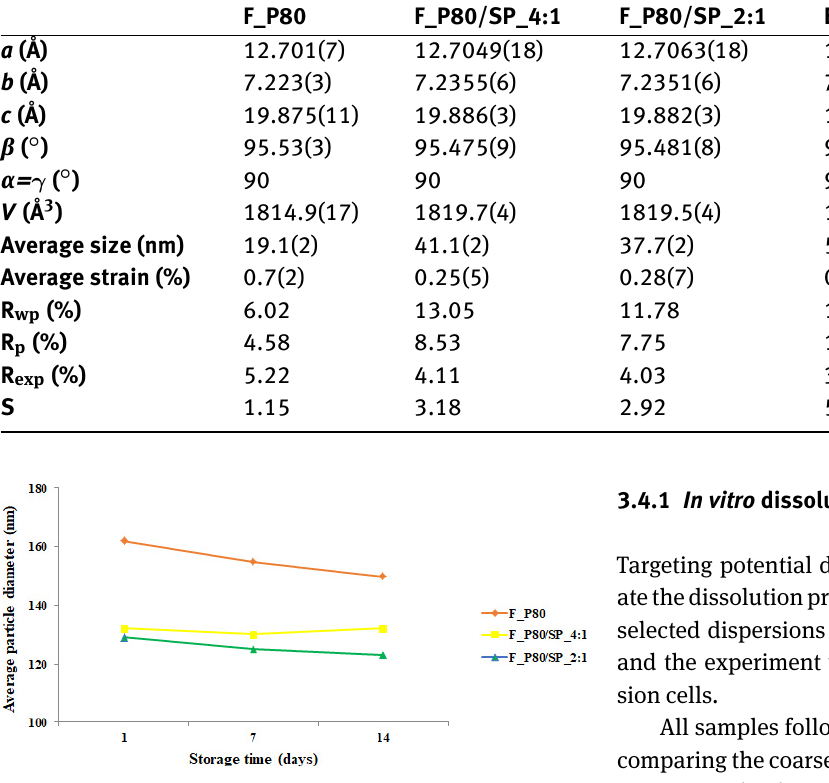
eral appearance of the samples).No agglomeration was ob- served (Figure 5) and no precipitation occurred during this short-term stability